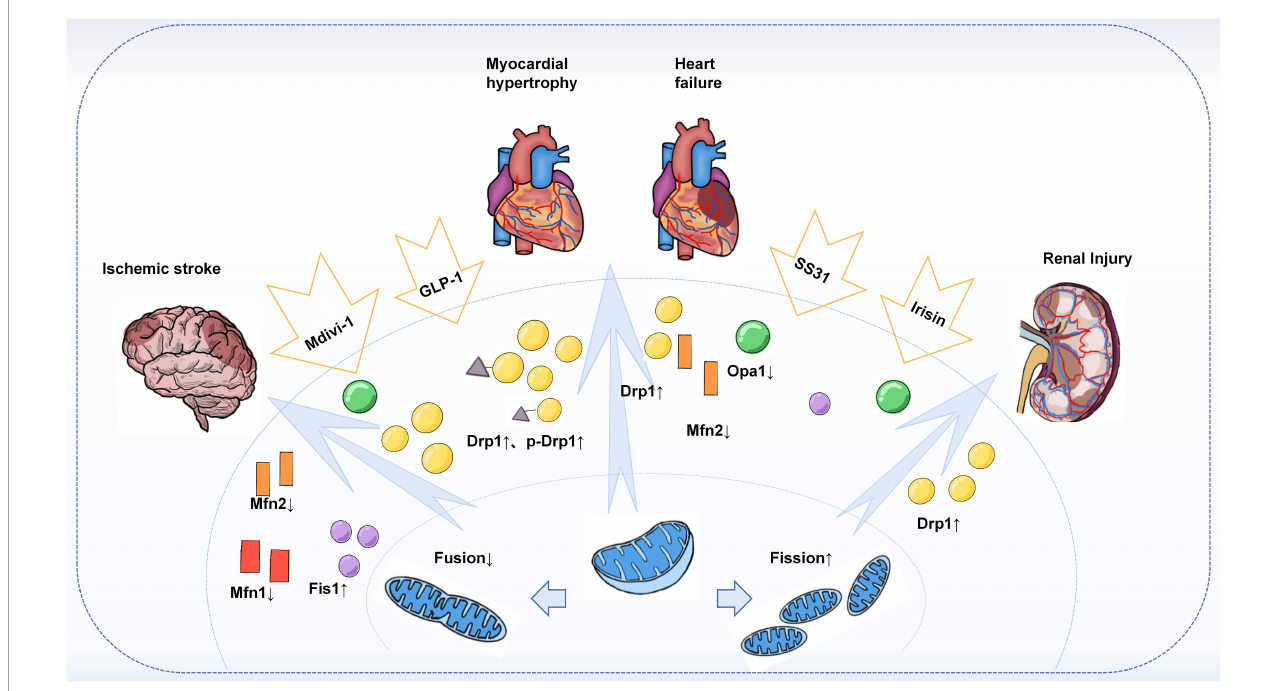
FIGURE3 Mitochondrial dynamics in target-organ injury. Increased Drp1 and phosphorylated Drp1 were observed in an animal or in vitro models of cardiac hypertrophy, heart failure, stroke, and acute and chronic types of kidney injury, leading to enhanced mitochondrial division and increased fragmented mitochondria. At the same time, the expression of fusion proteins Mfns, especially Mfn2, and Opa1 was found to be reduced. Treatment with Mdivi-1, an inhibitor of Drp1, restored the Drp1 to Mfn2 ratio and improved cardiac function, attenuated brain injury, and reduced apoptosis in the kidney. In